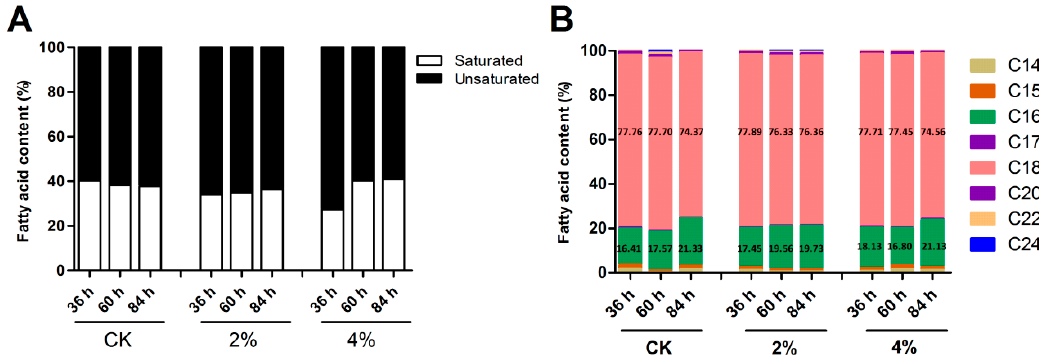
6 of 12 Figure 3. Transmission electron microscopy analysis of the adaptive response of A. oryzae to ethanol stress. Under conditions of 4% ethanol treatment, the segregated vacuoles became increasingly aggregated, and the cellular nuclei appeared swollen and lengthened. ( A,B ) A. oryzae cells without ethanol. ( C,D ) A. oryzae cells under 4% ethanol. M: mitochondria; N: nucleus; V: vacuole. 3.3. Determination of Intracellular Fatty Acid Compositions The alterations in membrane compositions play a crucial role in the stress response system, which enables the strains to thrive against ethanol pressure [7]. The relationship between ethanol tolerance and an increased degree of fatty acid unsaturation of membrane lipids has been well documented in S. cerevisiae [9]. In the present study, the fatty acid content profiles of A. oryzae grown at different levels of ethanol were quantified. Our results revealed that the contents of 18- and 16-carbon chain length fatty acids comprised the predominant fatty acids, accounting for approximately 76.7% and 18.7% of total fatty acids, respectively (Figure 4). The major fatty acids in